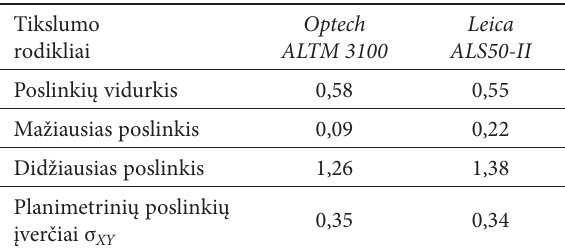
Table 3 . Results of planimetric accuracy Tikslumo